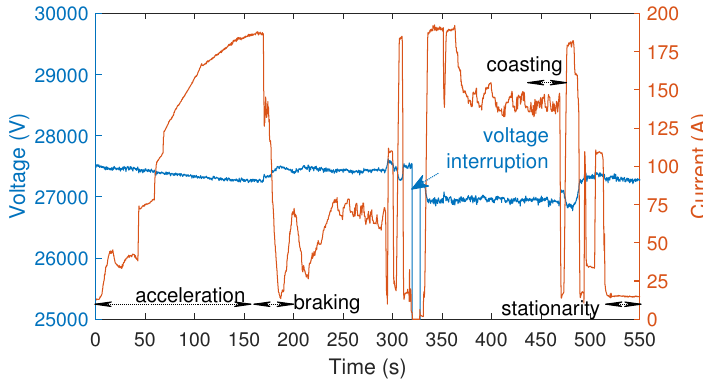
Figure 4. Voltage and current fundamental components.